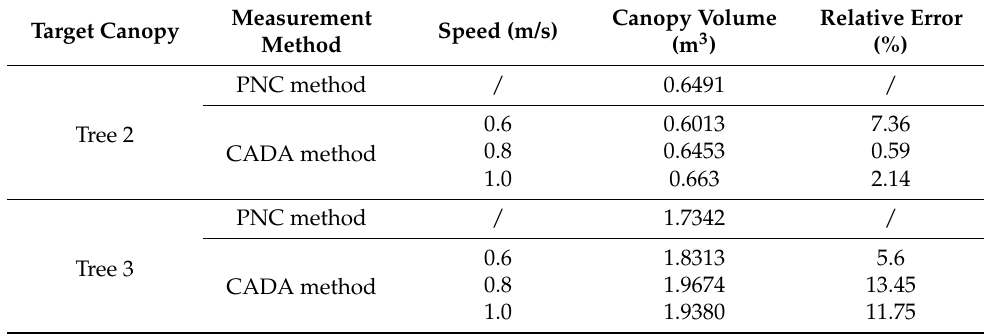
Table 6. Detection errors of different types of canopies.